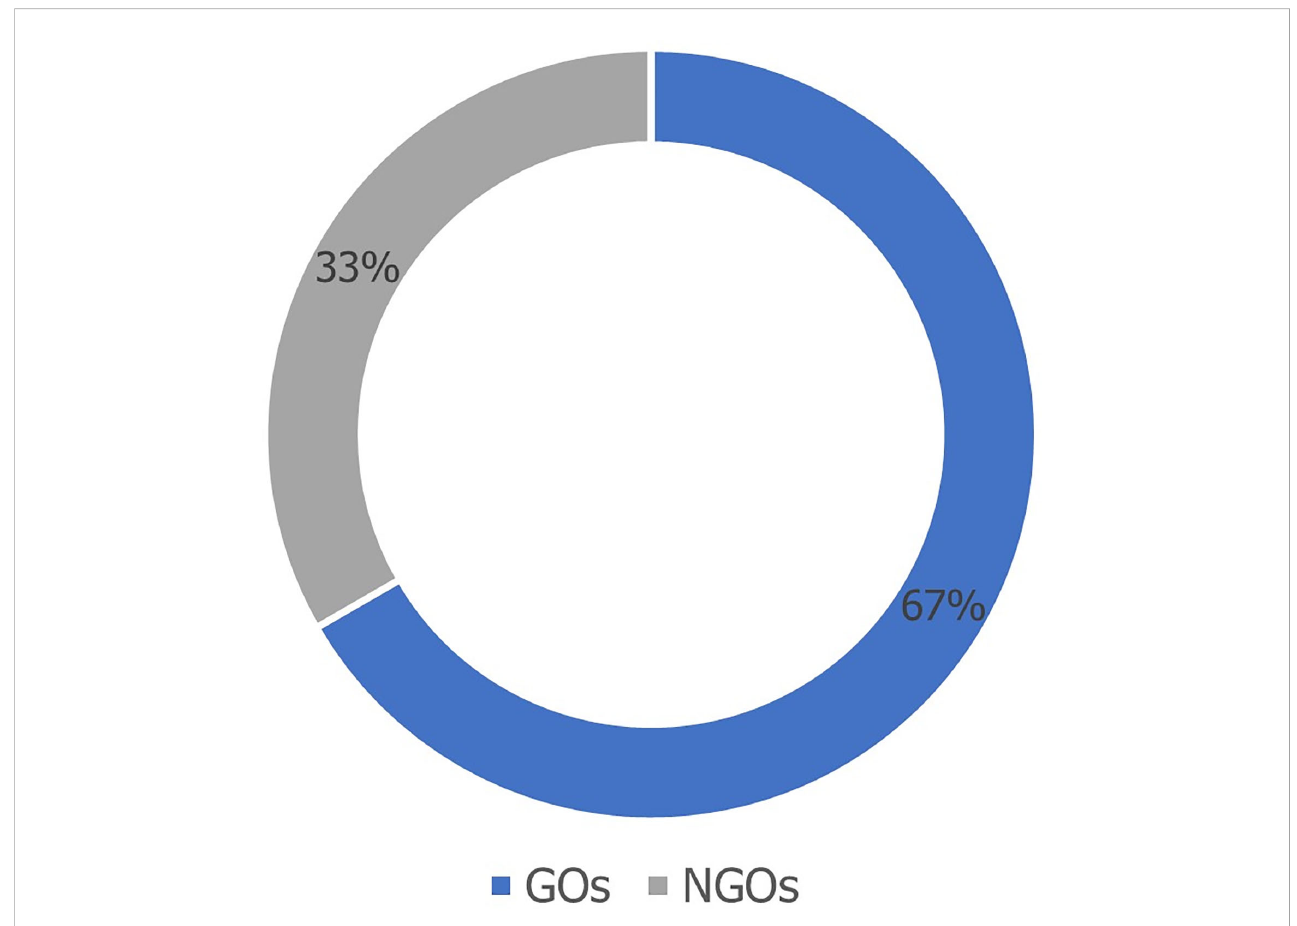
FIGURE 3 Participants by Af fi